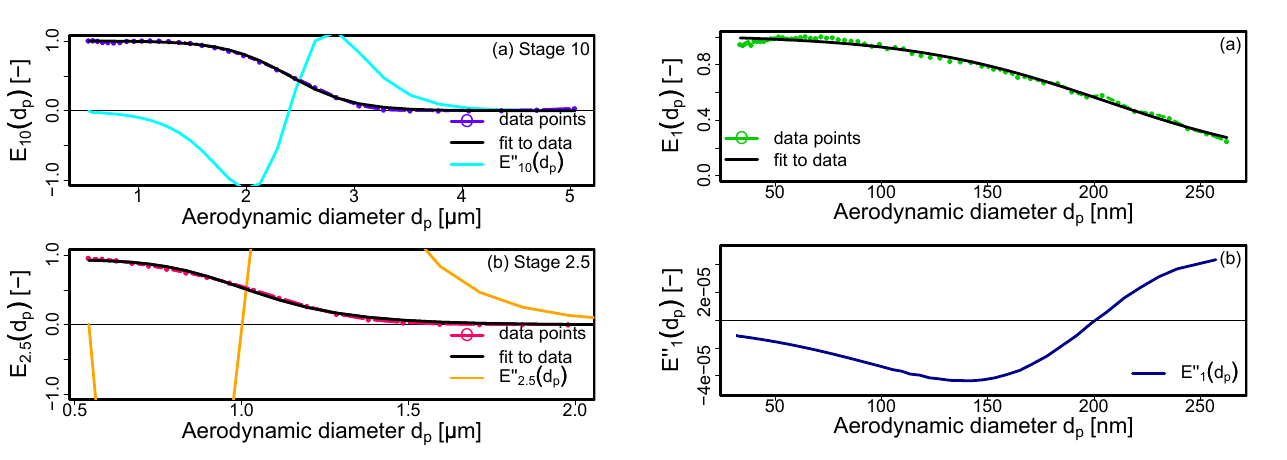
Fig. 4. Stage penetration curve E 1 (cid:0) d p (cid:1) for stage 1: ratio of size dis- tributions obtained with the SMPS connected to the RDI (setup B) versus size distributions obtained with the SMPS connected to the nebulizer (setup A). The upper panel (a) shows the data points and the sigmoidal fit. For better readability the second 00 (cid:0) d (cid:1) is shown on the p 2 . 5